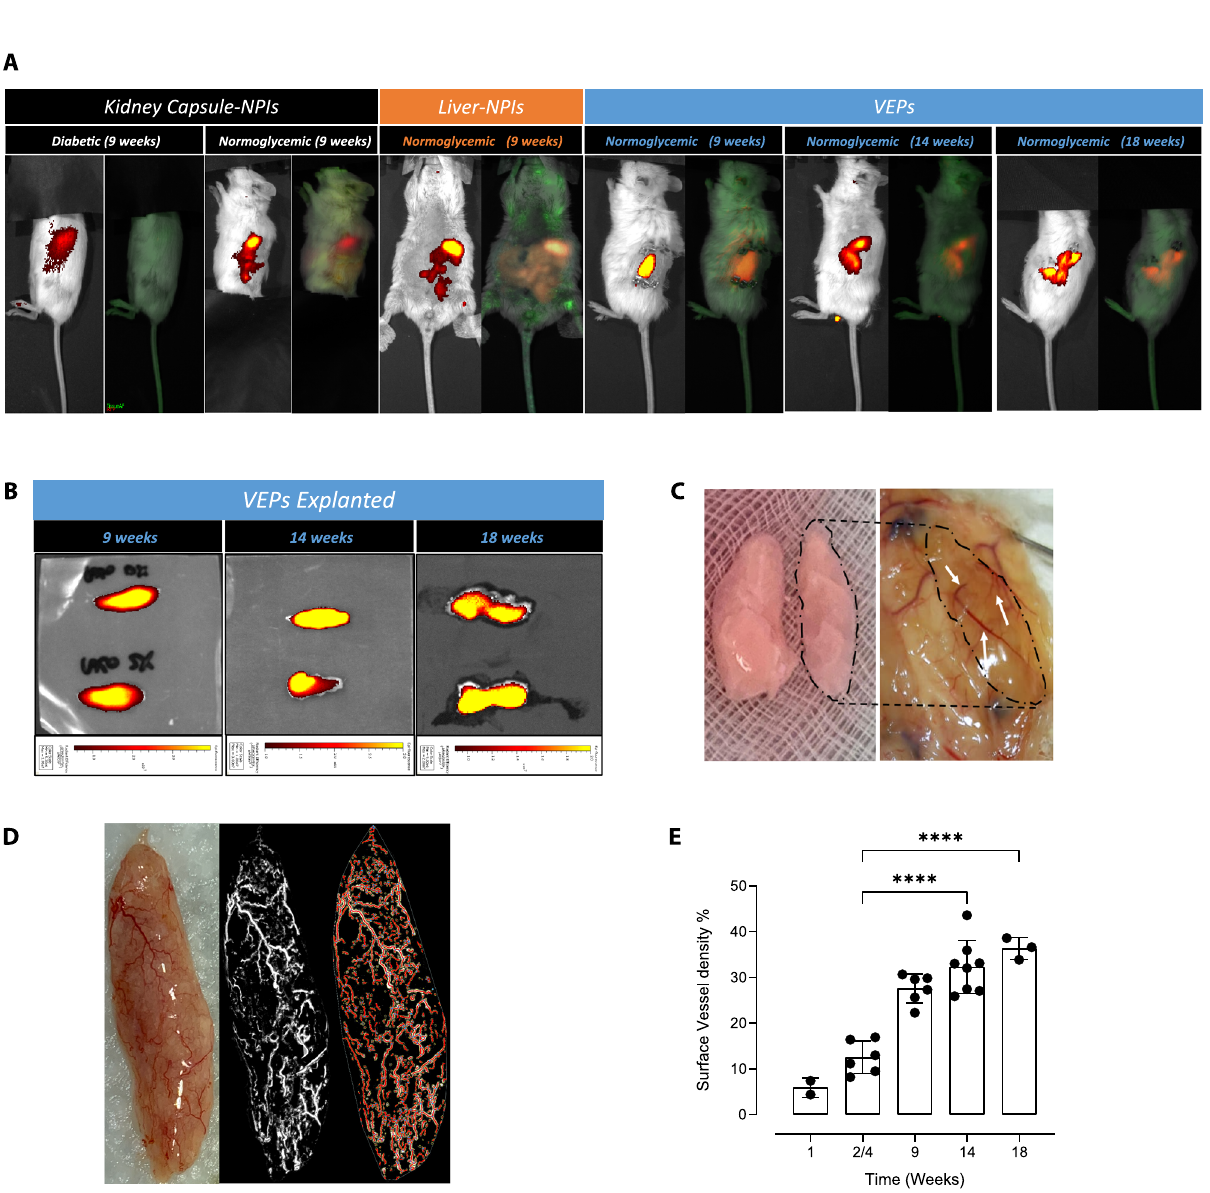
Fig.5|Long-terminvivoanalysisofVEPsgrafts.A IVISdetectionoftheiRFPNPIs signal in Kidney Capsule-NPIs (diabetic and normoglycemic), Liver-NPIs and VEPs (exclusively normoglycemic) at 9, 14 and 18 weeks. Right picture of each group represents the pure signal (orange-red) from the spectral unmixing deprived from tissue auto- fl uorescence (green). B 9, 14, and 18 weeks explanted VEPs IVIS detec- tion (iRFP signal — from red to yellow). C Image of VEPs pre-transplant and gross pathology 9 weeks after transplantation. D , E Vascular density analysis: D gross